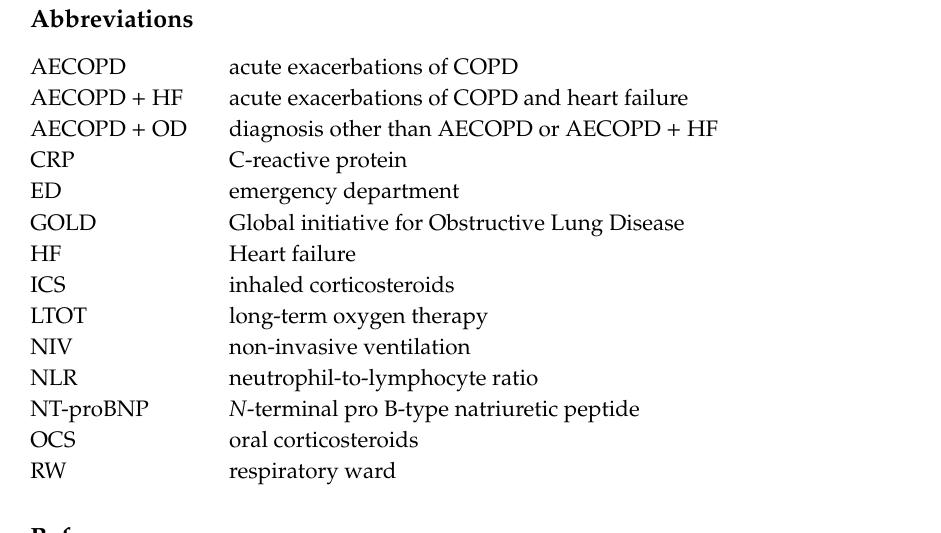
Figure S1: Patient flow chart, Table S1: Diagnostic tests available at Emergency Department (ED) and Respiratory Ward (RW) and frequency of use in the whole population of 119 patients, Table S2: Medications at baseline in whole population and in the three RW groups, Table S3: Comorbidities in whole population and the three RW groups, Table S4: Laboratory tests at ED visit according to the three RW diagnostic groups, Table S5: Laboratory and clinical data at the RW, Table S6: Risk factors for death after discharge from our RW, non-adjusted and adjusted